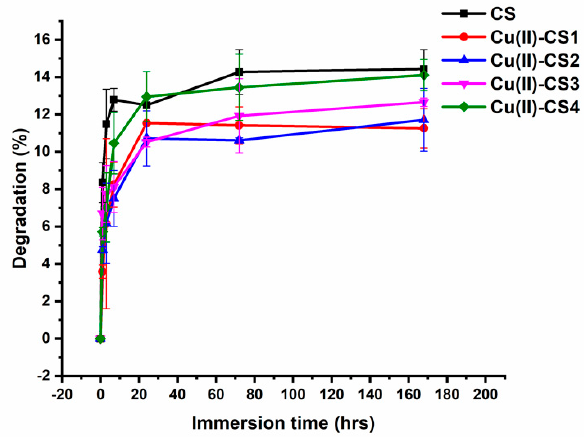
Figure 8. Degradation behaviour of CS and Cu(II)–CS coatings with di ff erent Cu(II) concentrations with respect to time in lysozyme–PBS solution.